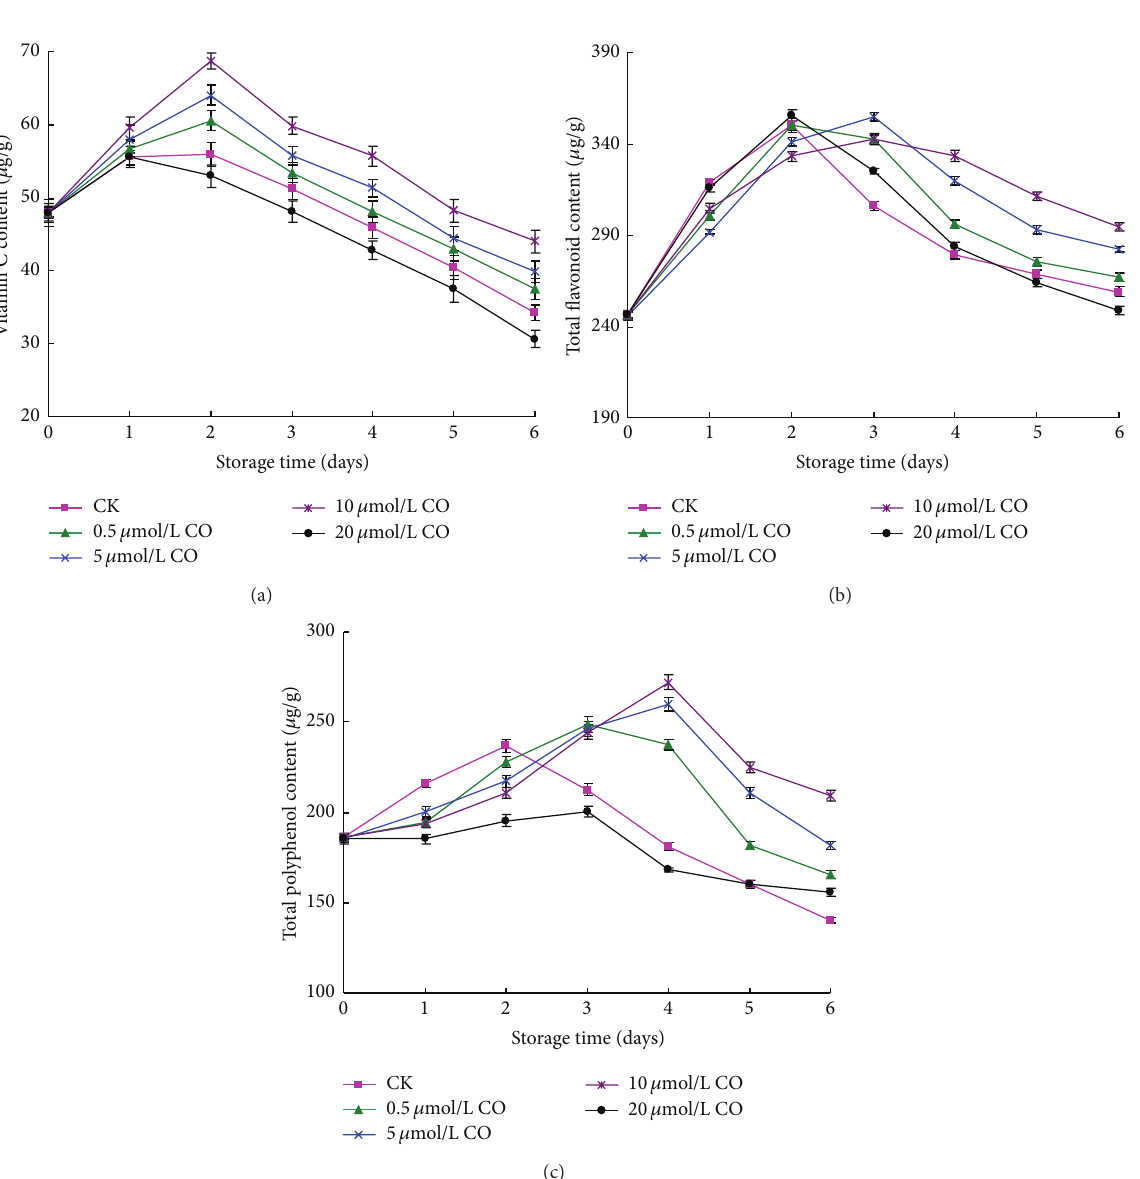
Figure 3: Effect of CO fumigation on vitamin C (a), total flavonoid (b), and total polyphenol (c) content of postharvest peaches. Each point represents the mean value ±